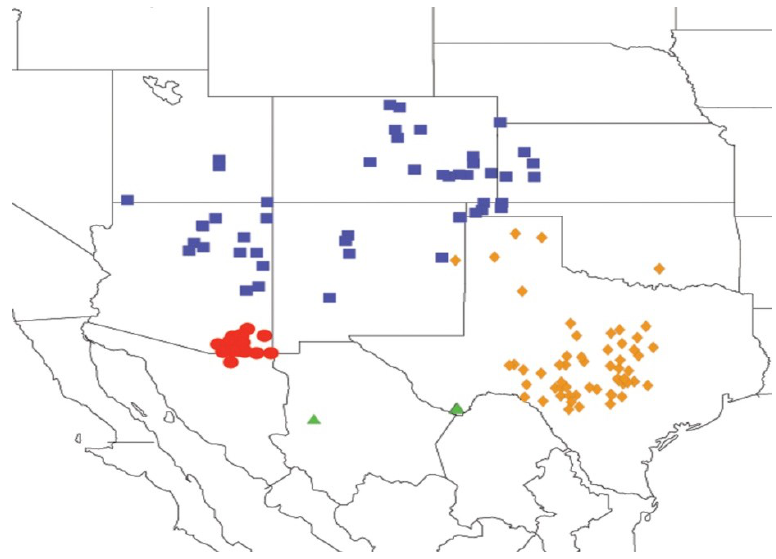
Figure 17. Distribution of Tibicen bifidus (blue squares), T. simplex (red circles), T. texanus (orange diamonds) and T. chisosensis (green